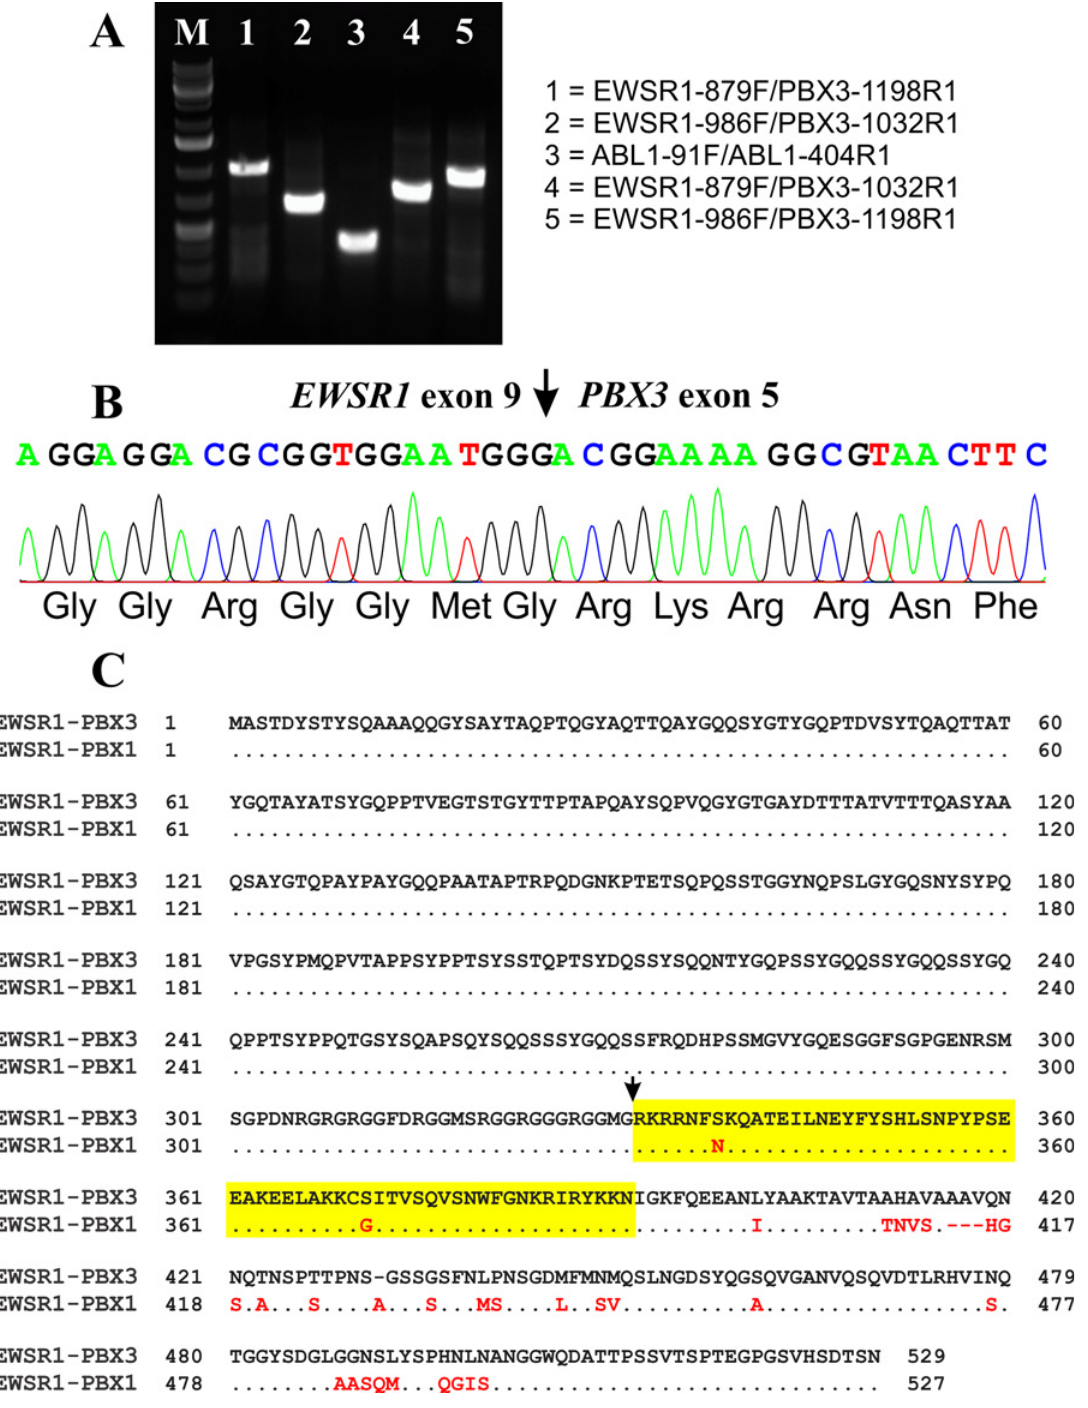
Fig 3. Molecular genetic data on the retroperitoneal leiomyoma. A) Gel electrophoresis of the RT-PCR amplified products using cDNA from the tumor. B) Partial sequence chromatogram of the amplified cDNA fragment showing the fusion point in the EWSR1-PBX3 fusion transcript. C) Sequence alignment of the EWSR1-PBX3 protein and EWSR1-PBX1 protein. Homeodomains are shown in yellow